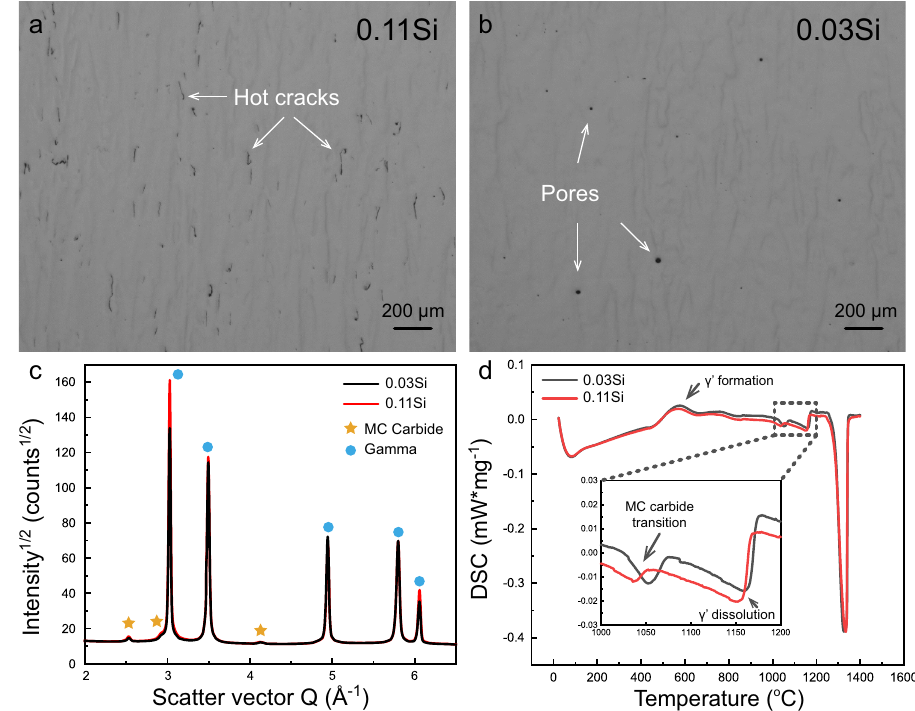
carbide phases in the as-built condition. d Differential scanning calorimetry (DSC) heating experiments revealed the γ ’ formation, MC carbide transition, and γ ’ dis- solution temperatures, respectively.